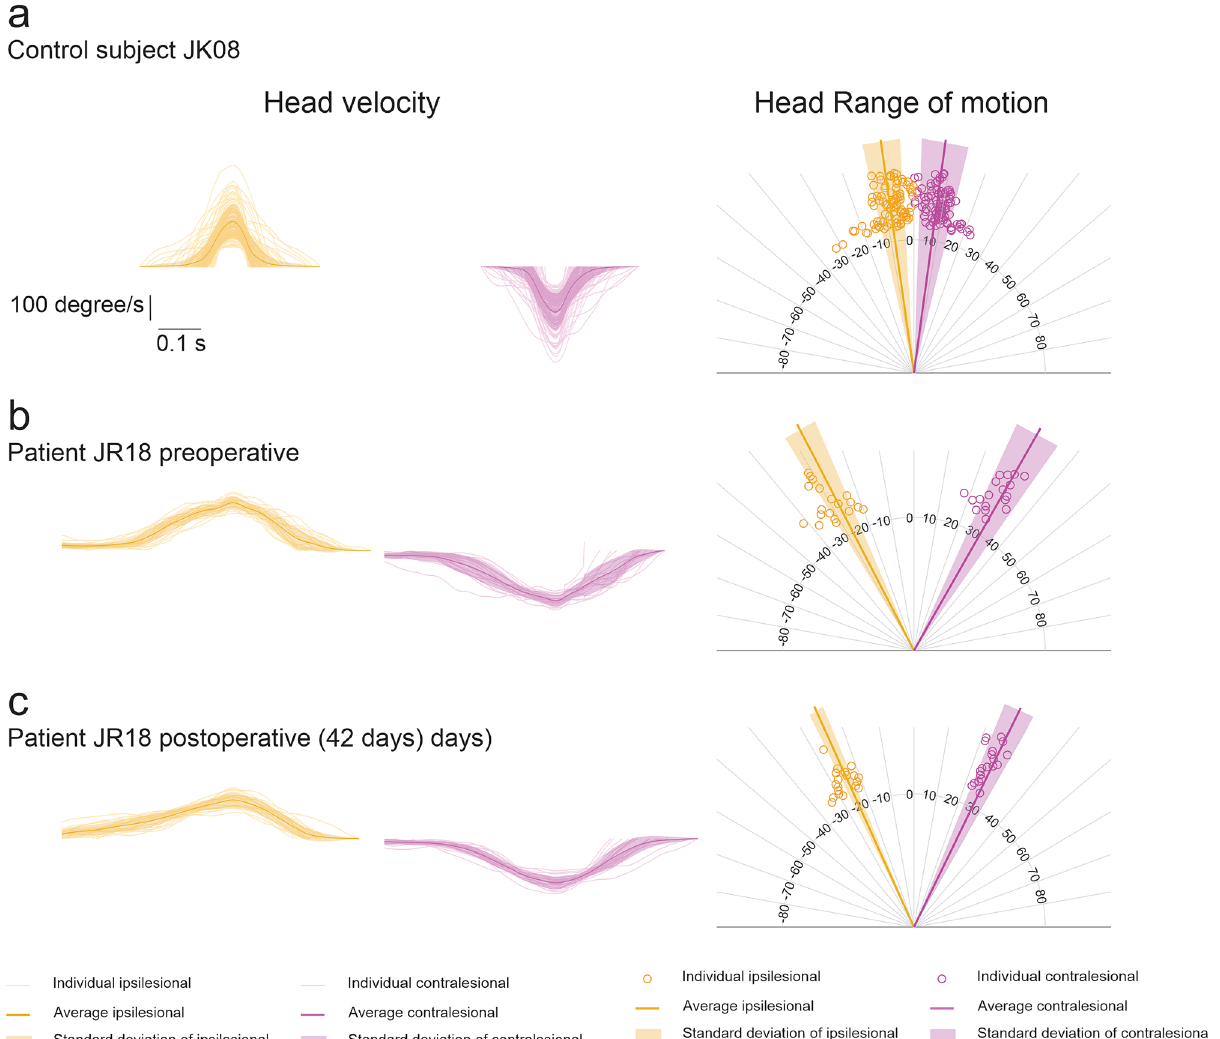
from the subject and fixed on the wall. The left panels show the head velocity traces from each head rotation cycle superimposed with the mean and standard deviation of head velocity. The right panels show the range of motion of each head rotation as well as the mean and standard deviation of the range of motion. Orange traces and circles indicate head rotation ipsilateral to the lesion side and magenta traces and circles indicate head rotation contralateral to the lesion